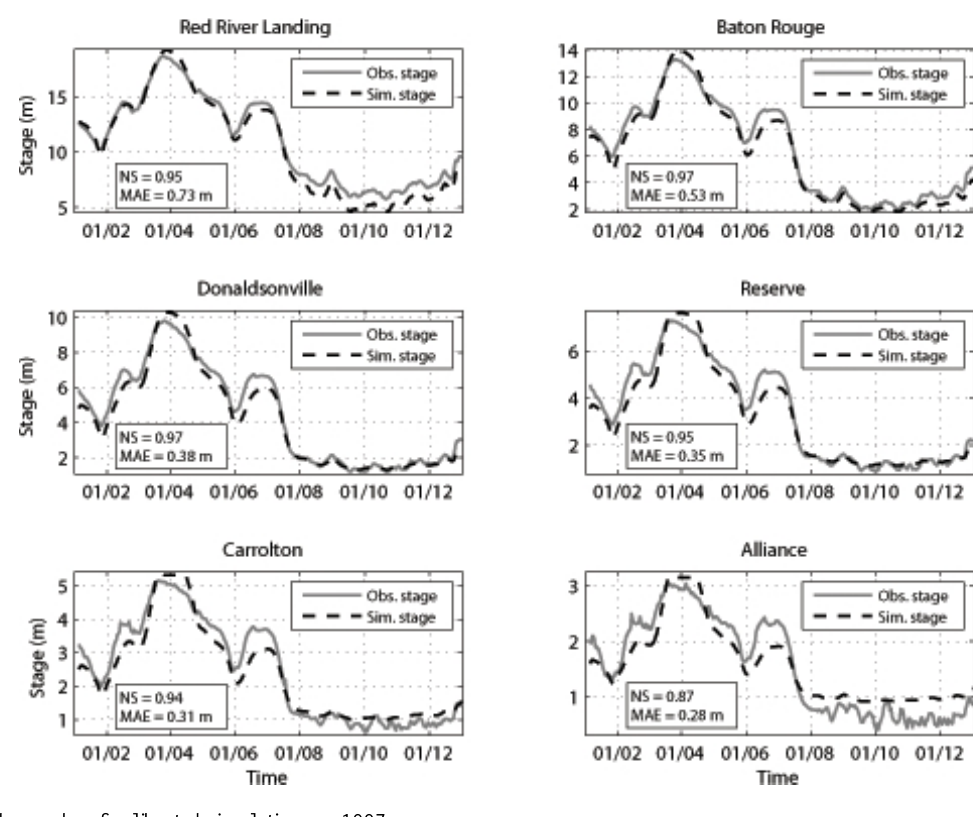
Figure 2. Hydrographs of calibrated simulation run